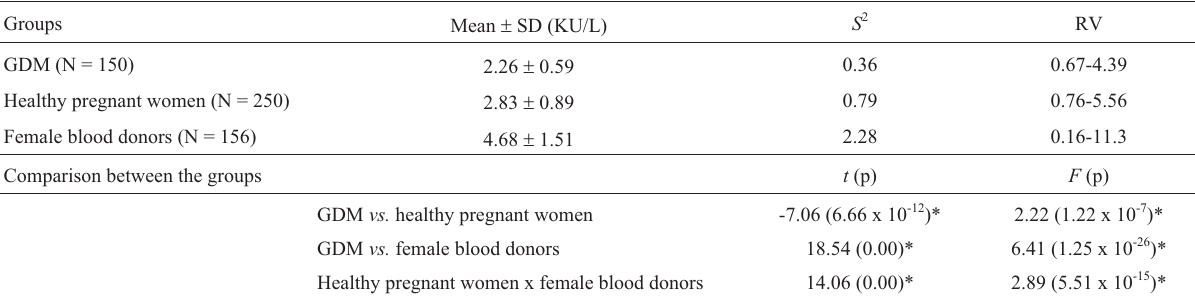
Table 2 - Butyrylcholinesterase activity (KU/L) in women with gestational diabetes mellitus (GDM), healthy pregnant women (controls) and female blood donors.